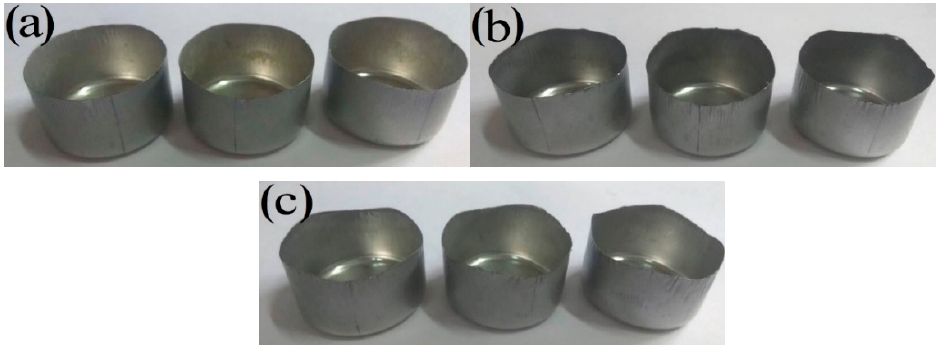
Figure 8. Experimentally drawn cups with different secondary cold reduction rates: ( a ) 15%; ( b ) 20%; ( c ) 25%.